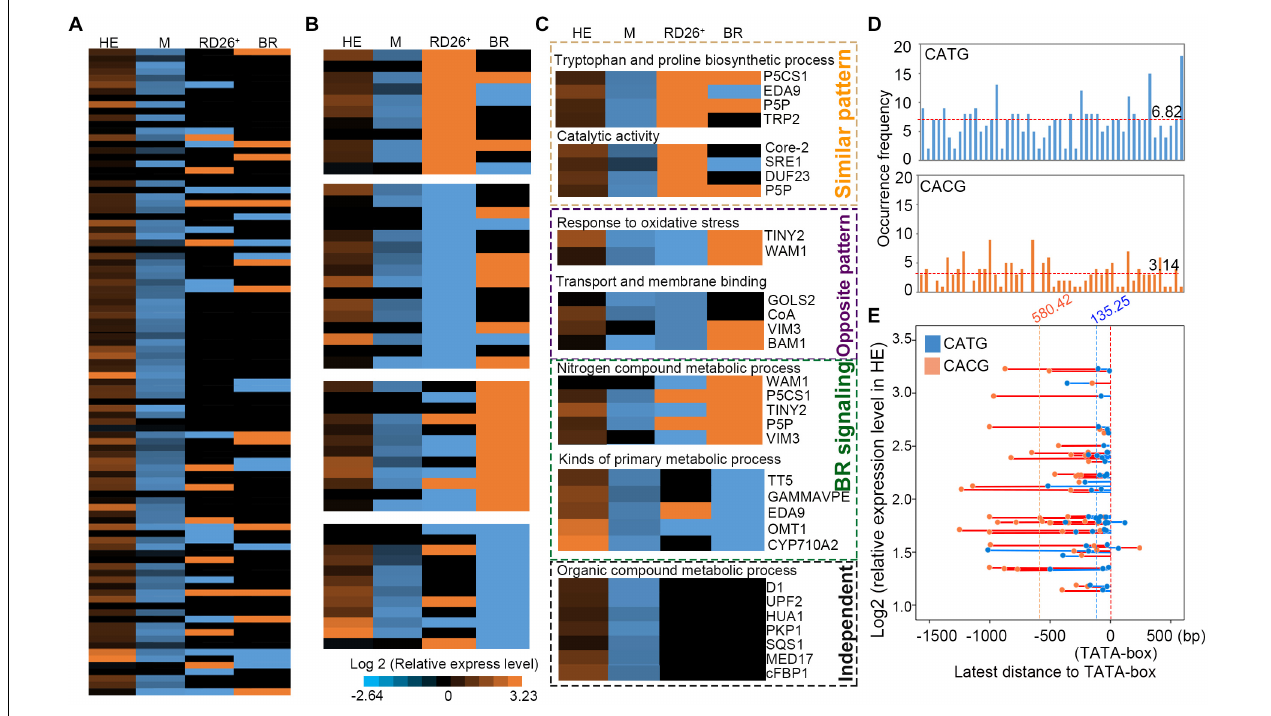
FIGURE 6 | Comparison of expression levels between the target genes of EsNAC1 in HE lines and up- or down-expressed genes in 35S:RD26 lines and the BR treatment of Arabidopsis . (A) The expression levels of genes were ranked referenced to the peak score in Chip-on-chip. HE, heterologous expression lines of EsNAC1 ; M, the mutant lines of RD26; RD26 + , the 35S::RD26 lines of Col-0 from Ye et al. (2017); BR, plants with the brassinosteroid treatment from Ye et al. (2017) (B) Genes were repermutated with reference to the positive- or negative-correlated expression pattern. (C) The orange dot box indicates genes with a similar expression pattern to that of the RD26OX line; the purple dot box marks genes with the opposite expression pattern compared with that of the RD26OX line; the green dot box labels genes for which expression changed after the BR treatment; the black dot box shows genes regulated by EsNAC1 independent of the BR signaling pathway and different from those of the RD26OX line. All data were normalized to the gene expression level in Col-0. (D) Occurrence frequency of CATG and CACG in promoter regions shown in a. Red dotted lines represent the mean occurrence frequency. (E) Distances between the latest CATG (blue) or CACG (orange) to the TATA-box against with the relative expression level of the gene in HE lines. Blue or orange dotted lines represented the means of these latest